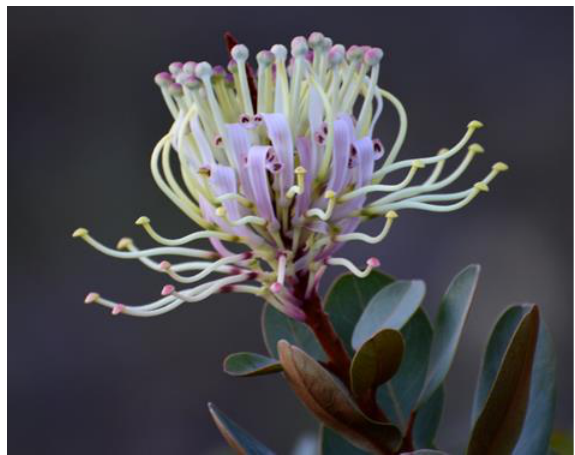
F IGURE 1: An individual of Oreocallis grandiflora from the study area, detail of an inflorescence. Photo by Pedro Machado